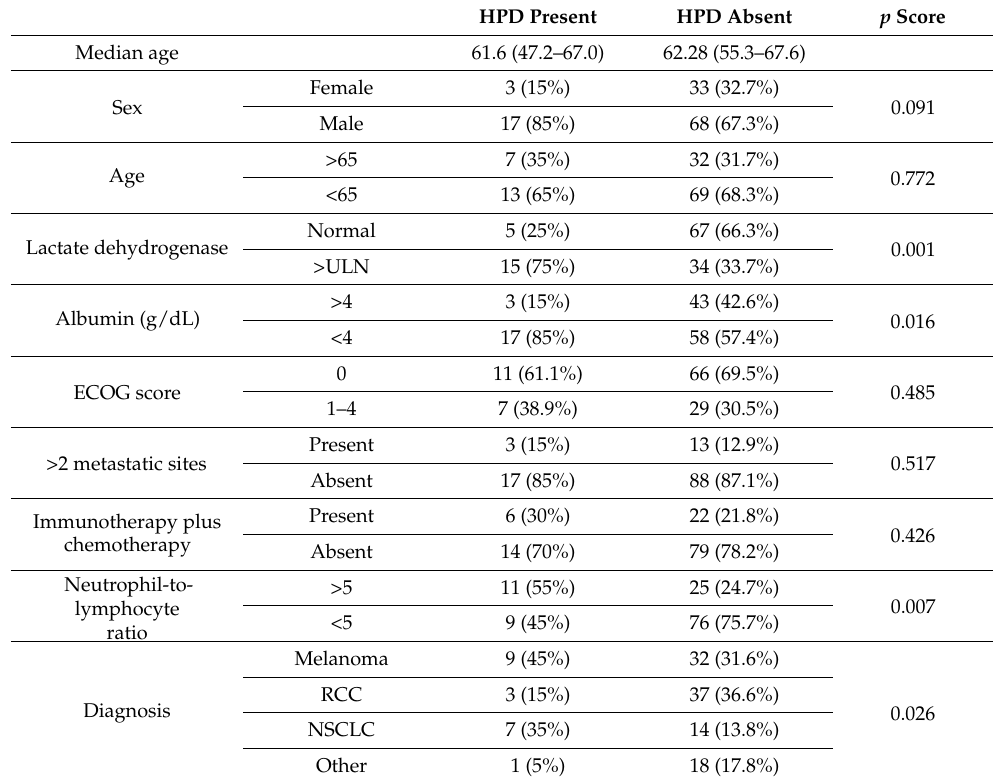
Table 2. Baseline clinical and laboratory features of patients with or without